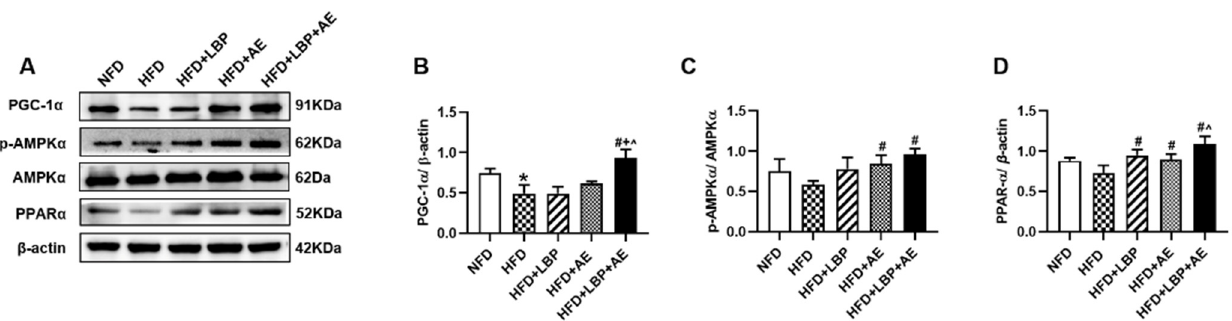
Figure 5. LBP plus AE activated AMPK/PPAR α /PGC-1 α pathway to ameliorate NASH. ( A – D ) Western blot images and quantitative band density analyses in different groups. * p < 0.05 vs. the NFD group. # p < 0.05 vs. the HFD group. + p < 0.05 vs. the HFD plus LBP group. ^ p < 0.05 vs. the HFD plus AE group. Three samples of mice in each group were used and western blot was repeated three times.